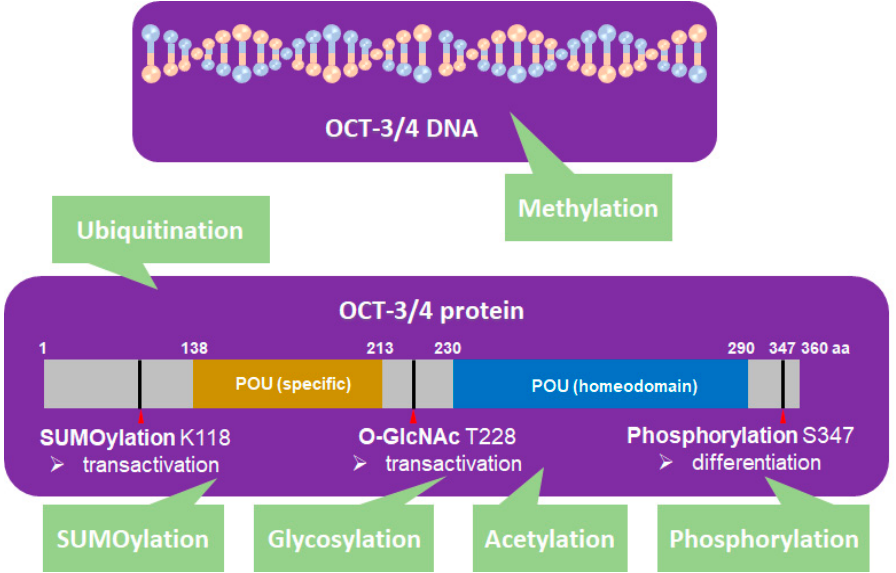
Figure 2. OCT-3/4 (PDM ID: 3L1P, https://www.ncbi.nlm.nih.gov/Structure/pdb/3L1P) is regulated by different kinds of posttranslational modifications (PTMs). SUMOylation (K118), glycosylation (T228), phosphorylation (S347), ubiquitination, methylation, and acetylation of OCT-3/4 regulate the pluripotency, differentiation, and self-renewal of stem cells.